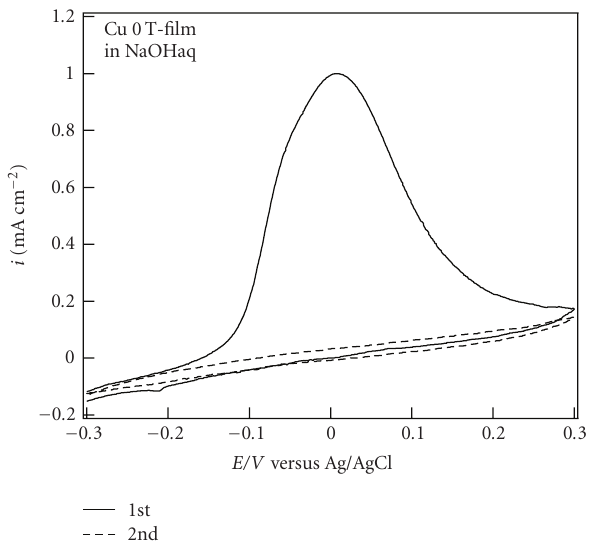
Figure 2: CVs of the Cu 0T-film electrode in a 0.1MNaOH aqueous solution. The 1st sweep (solid line) corresponds to the pretreatment of the Cu film electrode, and the 2nd sweep (dashed line) represents the background current. The potential sweep rate was 10mVs − 1 .